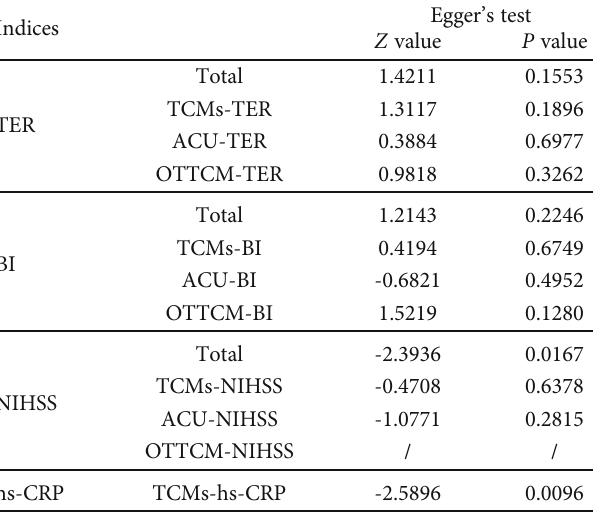
Table 11: Egger ’ s